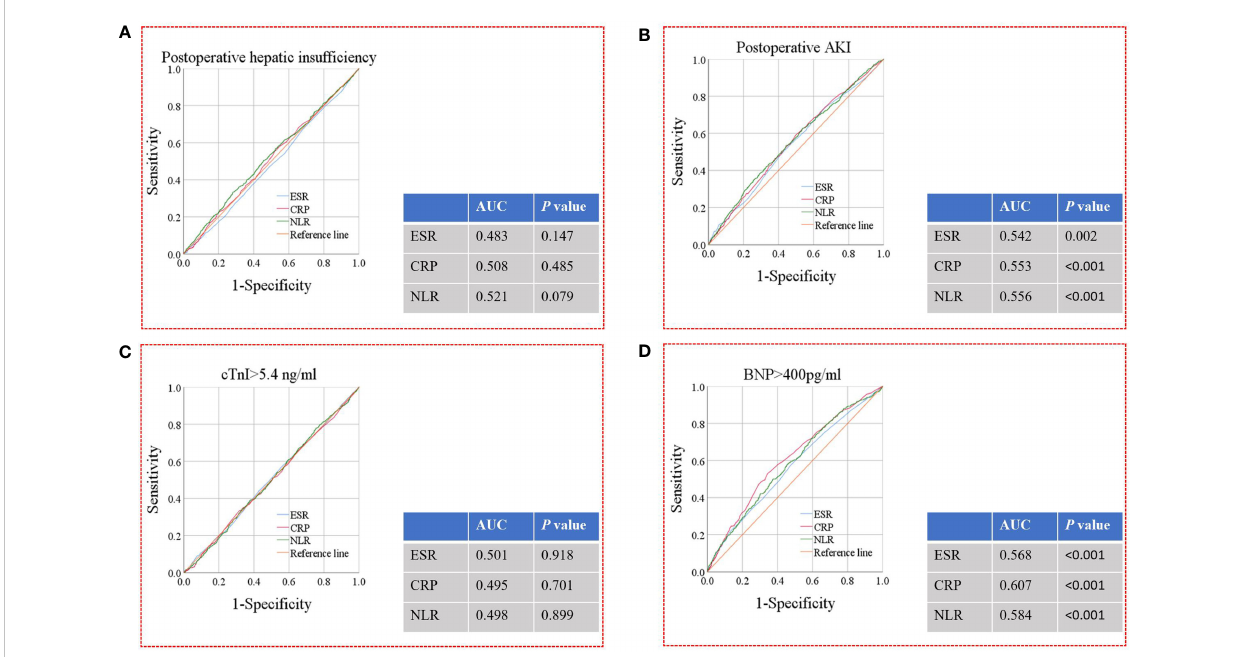
FIGURE 4 ROC analysis for ESR, CRP levels and NLR for the prediction of postoperative hepatic insuf fi ciency (A) , AKI (B) , cTnI level >5.4 ng/ml (C) , and BNP level >400 pg/ml (D) . ROC, receiver operating characteristic; AKI, acute kidney injury; ESR, erythrocyte sedimentation rate; CRP, C-reactive protein; NLR, neutrophil-to-lymphocyte ratio; AUC, area under the curve.